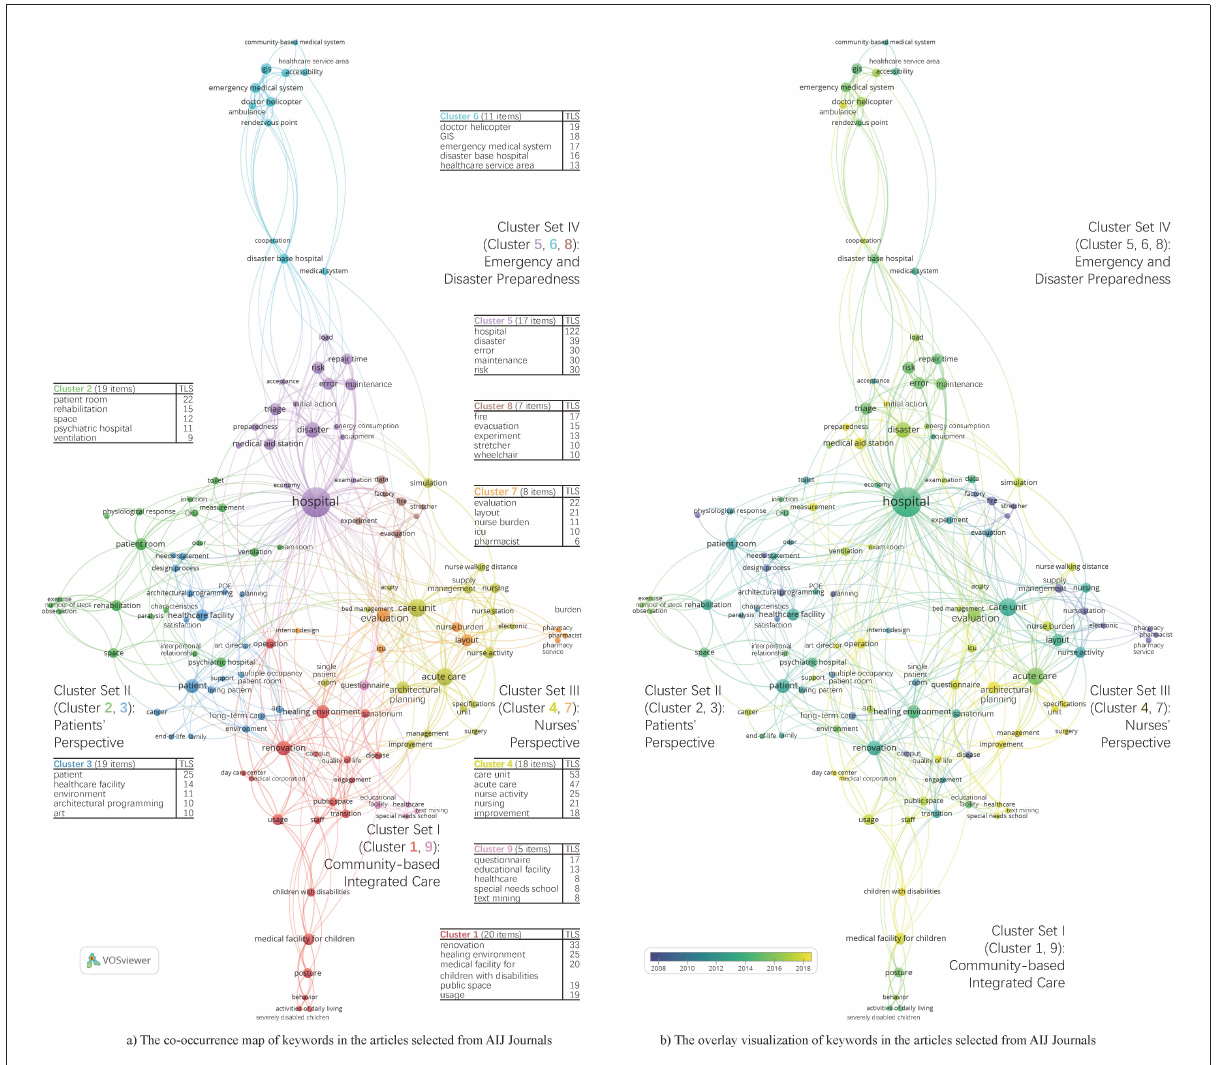
FIGURE3 Keywords analysis of the articles selected from AIJ journals. (A) The co-occurrence map of keywords in the articles selected from AIJ journals. (B) The overlay visualization of keywords in the articles selected from AIJ